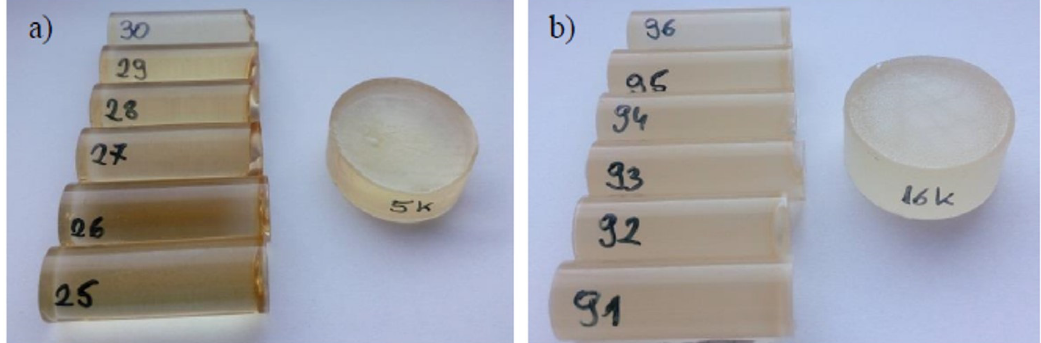
Figure 2. Real view of cured epoxy adhesive samples: ( a ) unmodified (Epidian 53/Z-1); ( b ) modified (Epidian 53/Z-1/CaCO 3 )